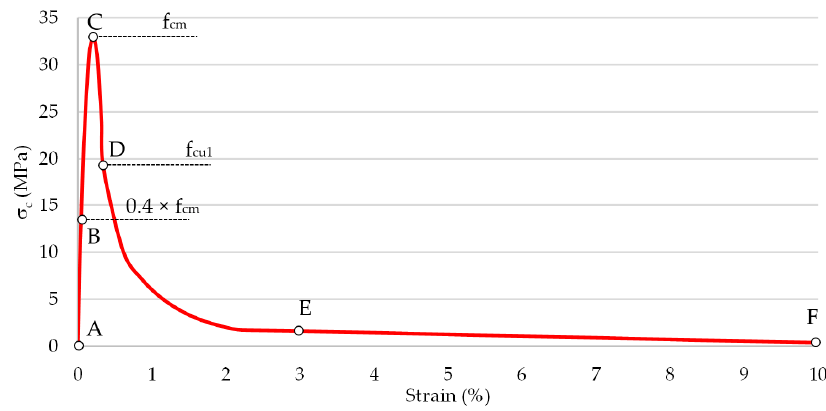
( b ) Figure 12. Parameters of concrete in compression: ( a ) stress–strain relation of concrete for structural analysis based on EN 1992-1-1; ( b ) concrete stiffness degradation in compression. As presented with Equation (13) and Figure 12, the plasticity curve in EN 1992-1-1 is defined only up to nominal ultimate strain ε cu1. In cases when high crushing strains are expected, the extensions of the Eurocode model can be used as presented in the paper [23]: ( )